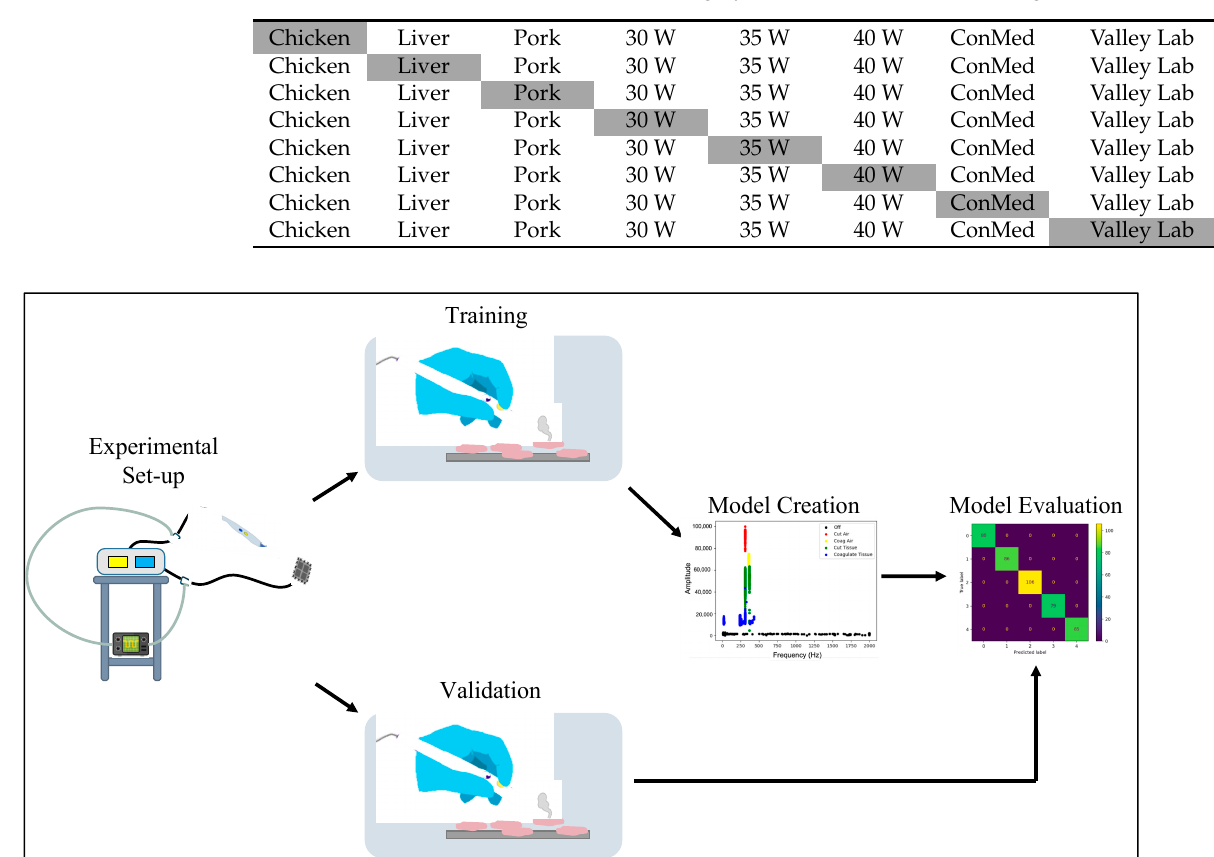
Table 2. Overview of 8-fold cross-validation (grey = validation, white = training).